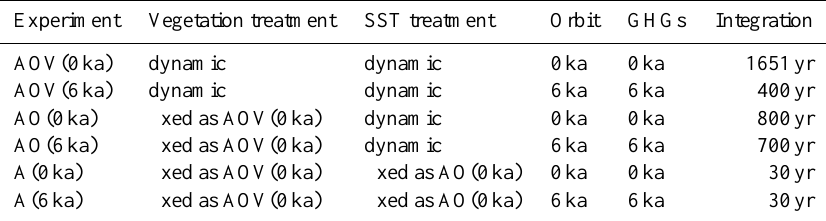
Table 2. Summary of